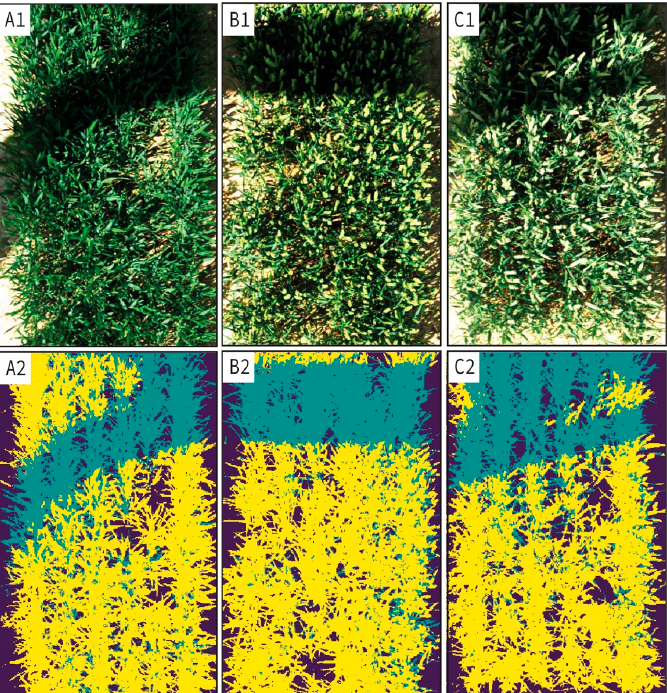
Figure 4. Classification maps; ( A1 , B1 , C1 ) examples of digital images of the same wheat cultivar over the growing season. The pseudo-RGB images (R:620 nm, G:535 nm, B:445 nm). are generated from the hyperspectral imaging; ( A2 , B2 , C2 ) the classification map obtained by the proposed algorithm which separates sunlit (S-All) and shaded pixels (SH-All) from the background. Remote Sens. 2021 , 13 , x FOR PEER REVIEW